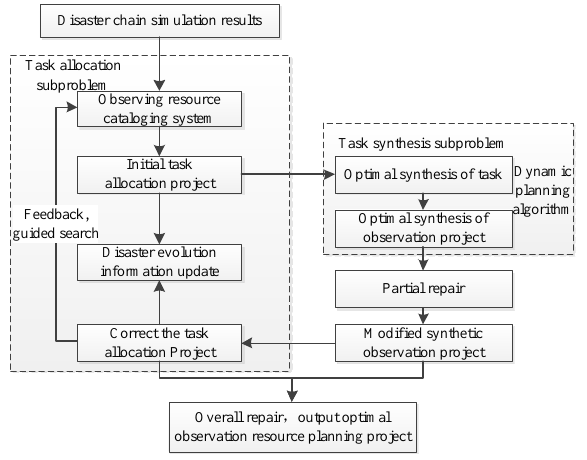
Figure 3. The algorithm structure based on decomposition